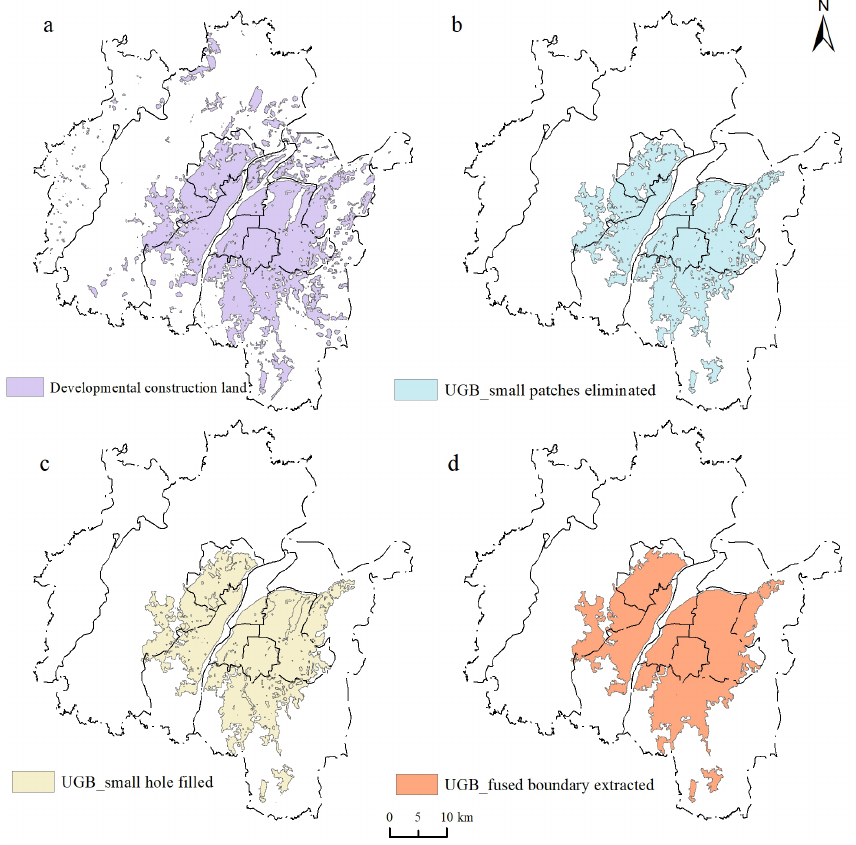
Figure 5. Schematic diagrams showing the extraction process of the revised urban growth boundary (UGB) in the study area in 2025 based on the natural development scenario (( a ) developmental construction land; ( b ) small patches eliminated; ( c ) small holes filled; ( d ) fused boundary extracted).